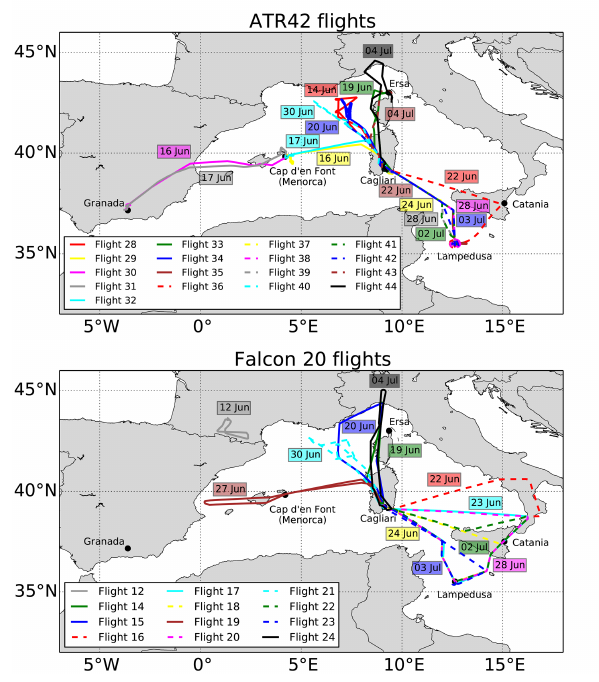
Figure 3. Overview of the different ATR-42 and F-20 flight trajec- tories performed during the SOP-1a